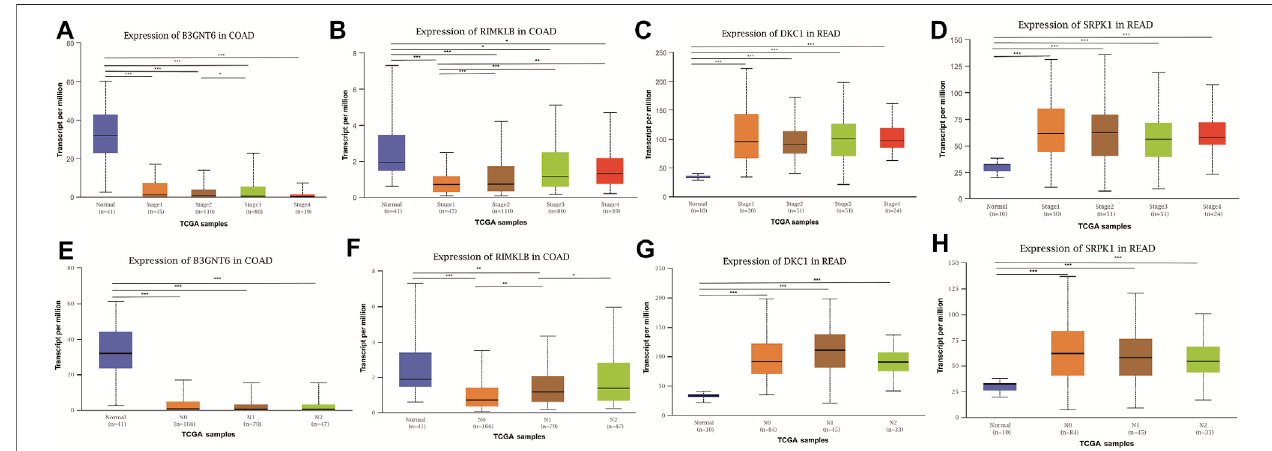
FIGURE 6 | Relationship between the expression of differentially methylated and expressed genes with CRC staging and lymphatic metastasis. Expression of B3GNT6 (A,E) , RIMKLB (B,F) , DKC1 (C,G) , SRPK1 (D,H) in normal tissues or tumour tissues with different clinical staging and lymphatic metastasis. (* p < 0.05, ** p < 0.01, *** p < 0.001).